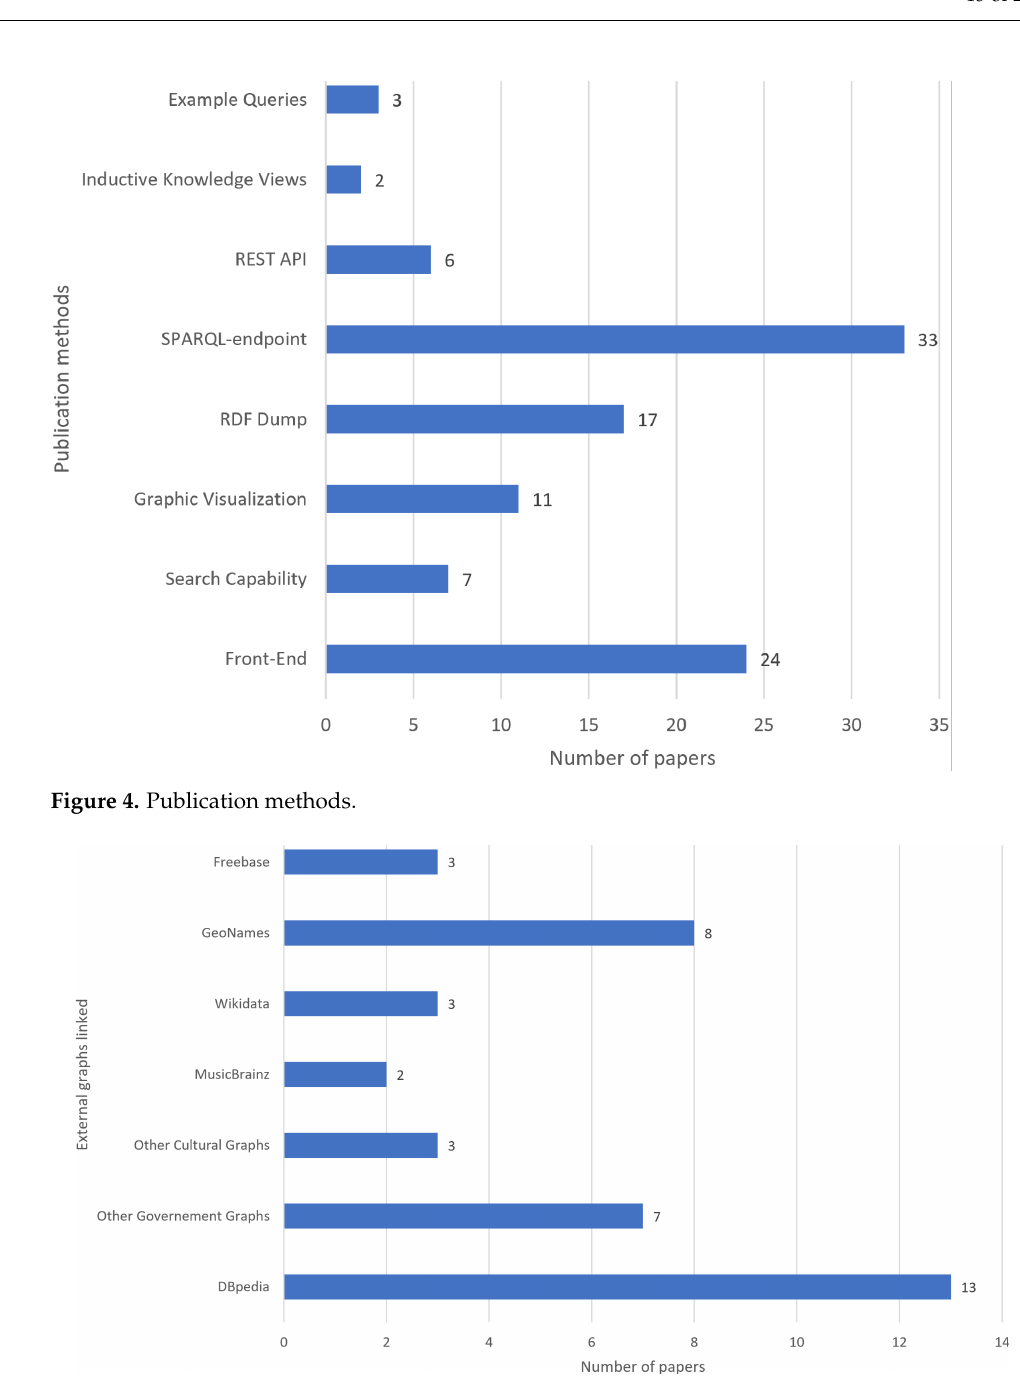
Figure 5. Links to other